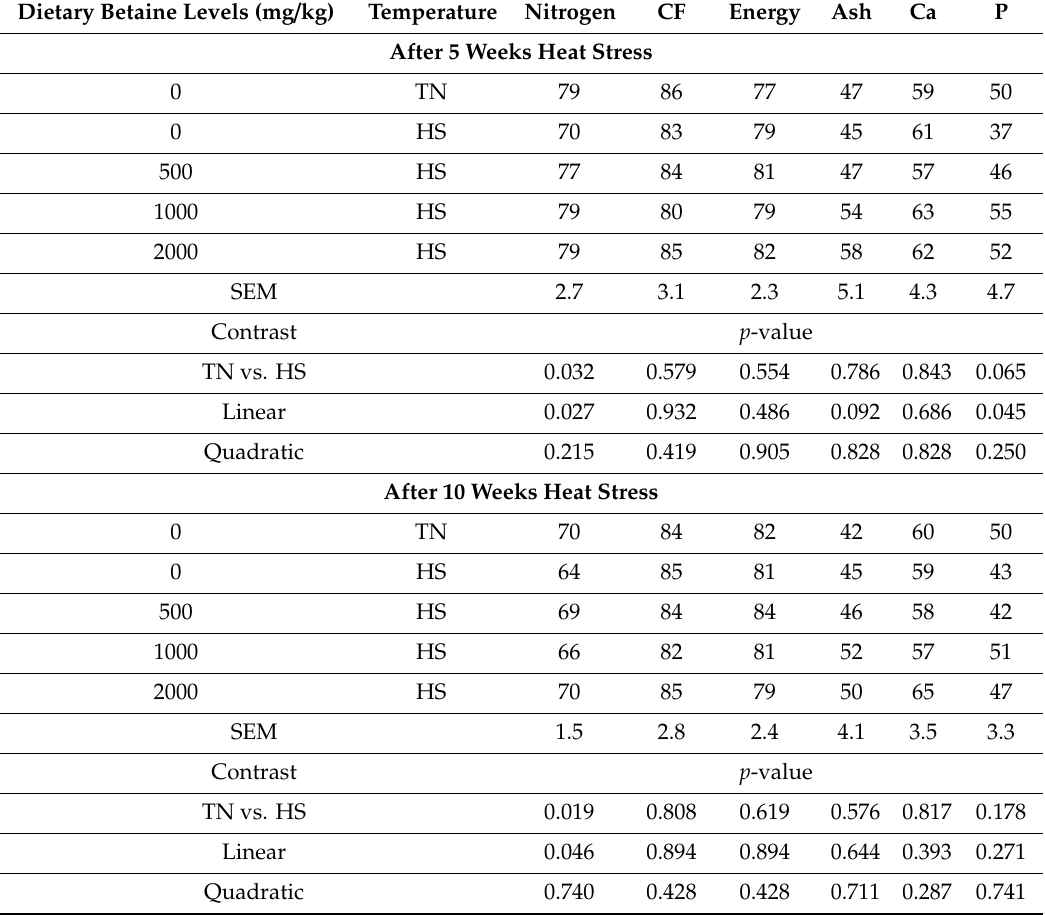
Table 3. E ff ects of heat stress and dietary betaine on nutrient retention of yellow-feathered broilers *, %. Dietary Betaine Levels (mg /